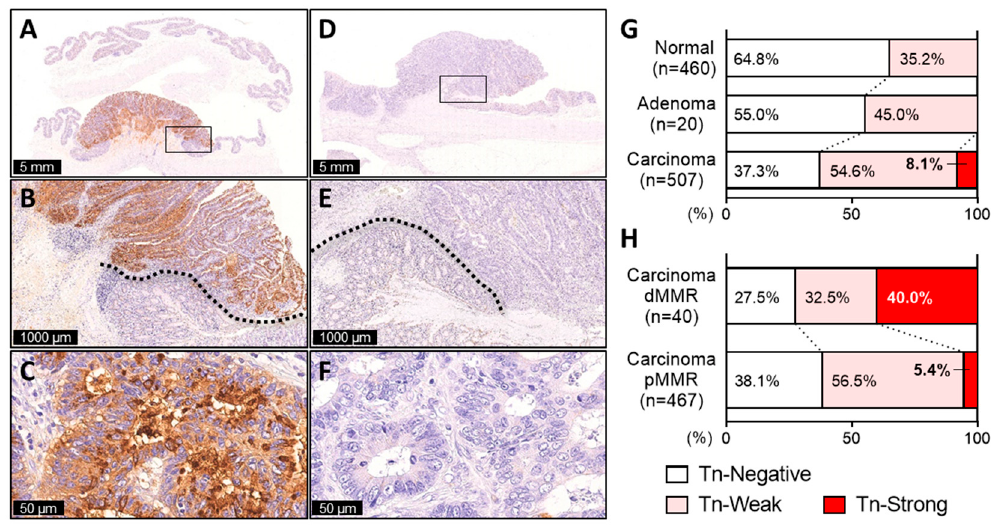
Figure 1. Immunohistochemistry for Tn antigen identifies a Tn-strong subset of colorectal cancer associated with deficient mismatch-repair (dMMR). ( A – C ) Representative images of a resected specimen of dMMR tubular adenocarcinoma showing diffuse and intense distribution of Tn antigen immunoreactivity (Tn-strong) in the tumor, but not in adjacent non-tumor mucosa. ( D – F ) Representative images of a resected specimen of proficient mismatch-repair (pMMR) tubular adenocarcinoma showing Tn-negative expression. ( G , H ) Relative proportion of Tn-negative, Tn-weak, and Tn-strong in non-tumor mucosa, adenoma, and carcinoma samples ( G ) or in dMMR and pMMR carcinoma samples ( H ).